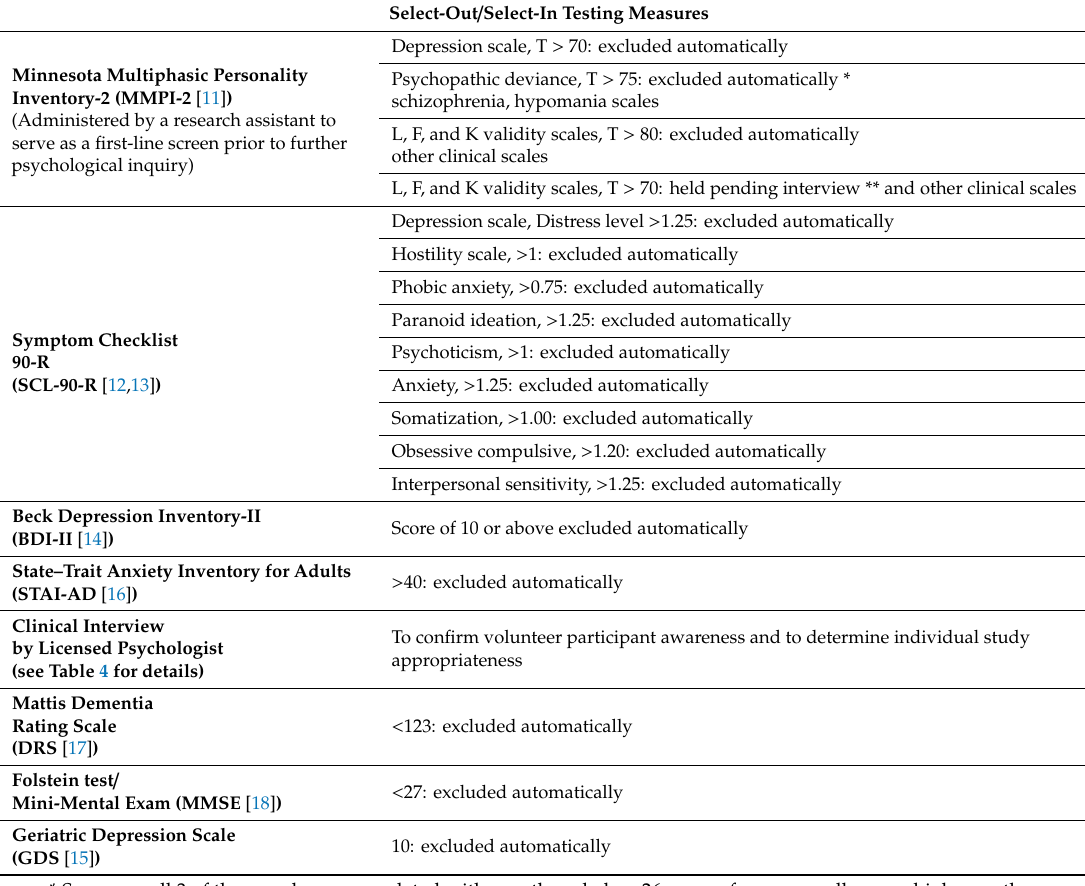
Table 3. Select-Out / Select-In testing